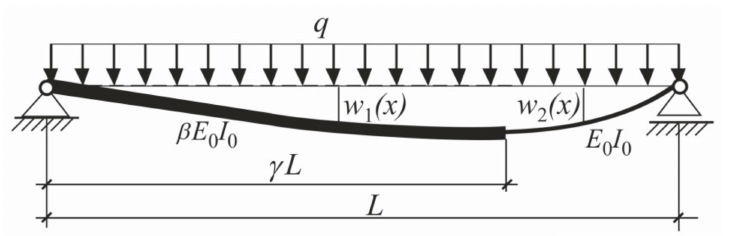
Figure 3. Deflections w 1 ( x ) and w 2 ( x ) caused by the uniformly distributed